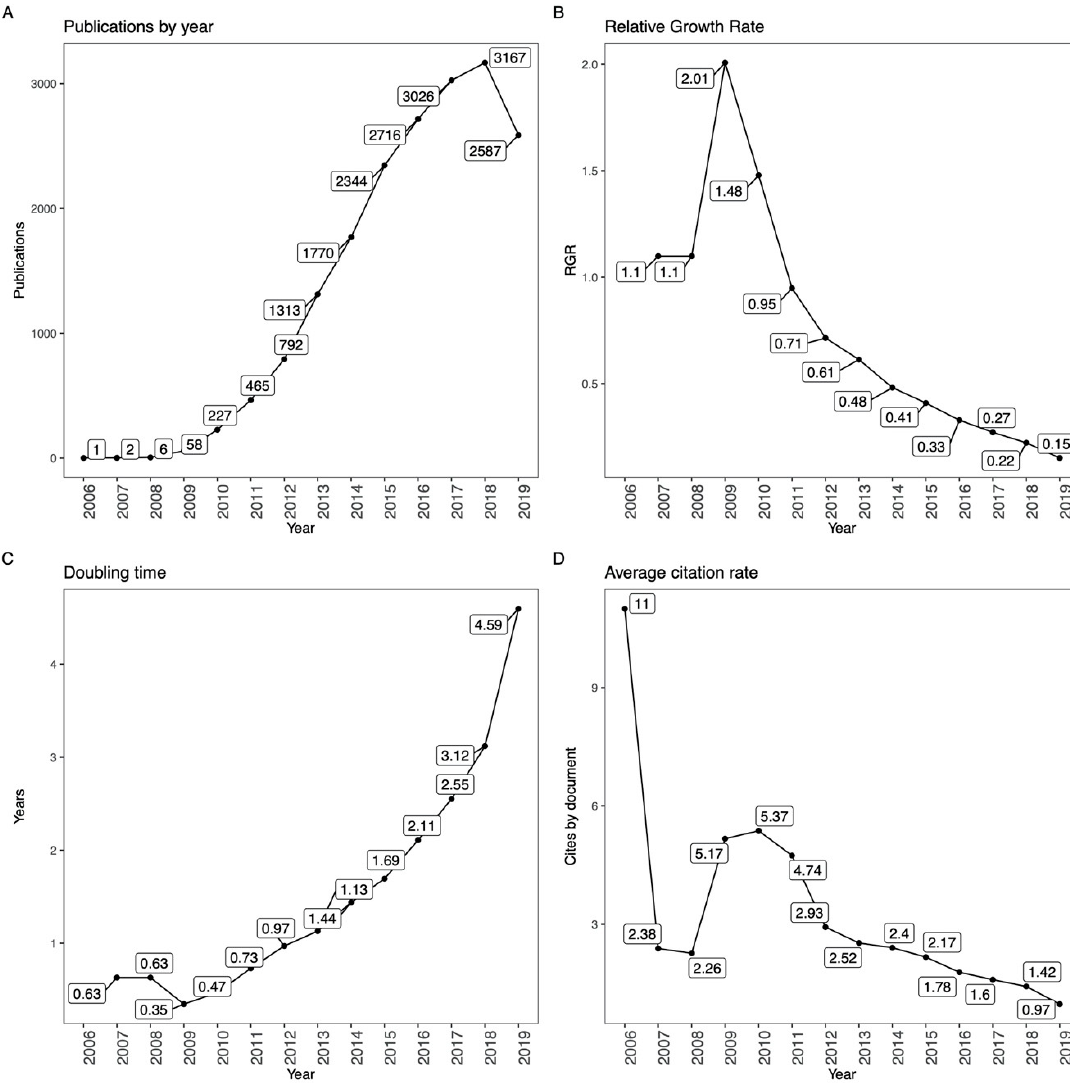
Figure 2. Annual Scientific Production, RGR = (ln c2 – ln c1) / (t2 – t1), ln = natural logarithm, cl = cumulative number of publications in period one, c2 = cumulative number of publications in period two. DT = ((t2 – t1)* ln 2) / (ln c2 – ln c1). ACR = citations / documents / years_since_publication. ( a ) Publications by year, ( b ) relative growth rate, ( c ) doubling time, ( d ) average citation rate.